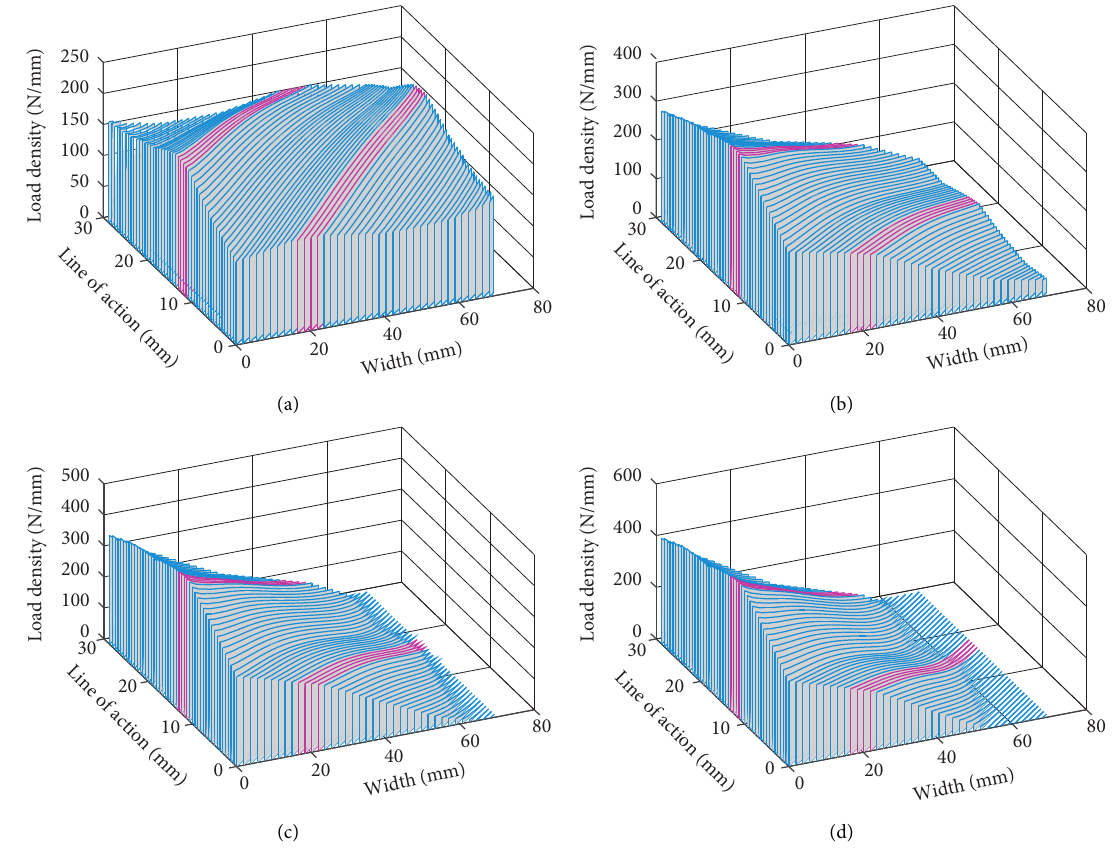
Figure 14: Load distribution of unmodified helical gear pairs under different mesh misalignment conditions. (a) 0 μ m. (b) 20 μ m. (c) 30 μ m. (d) 40 μ